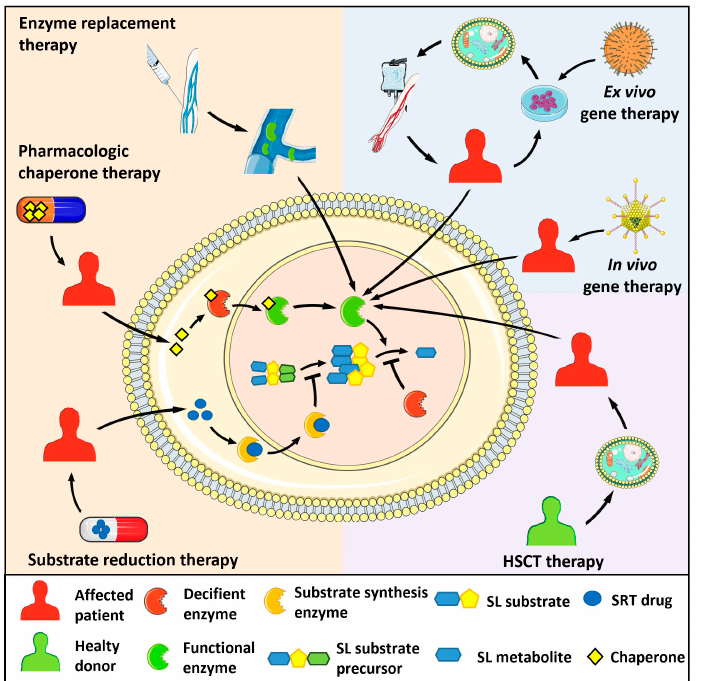
Figure 3. Therapeutic strategies for the treatment of sphingolipidoses. Enzyme replacement therapy consists of the intravenous administration of a bioactive recombinant form of the deficient enzyme. Pharmacologic chaperon therapy favours the proper folding of the mutated, misfolded enzyme and its lysosomal translocation, allowing the hydrolysis of the engulfing sphingolipid (SL) substrate. In substrate reduction therapy (SRT), drugs inhibit the activity of the enzyme responsible for the synthesis of the SL substrate of the deficient enzyme, hampering its lysosomal accumulation. In hematopoietic stem cell transplantation (HSCT), healthy donor-derived cells provide the patient with cells expressing the functional enzyme. Ex vivo gene therapy administers a bioactive enzyme by autologous transplantation of genetically modified hematopoietic stem cells. In vivo gene therapy consists of the injection of viral vectors encoding for the functional